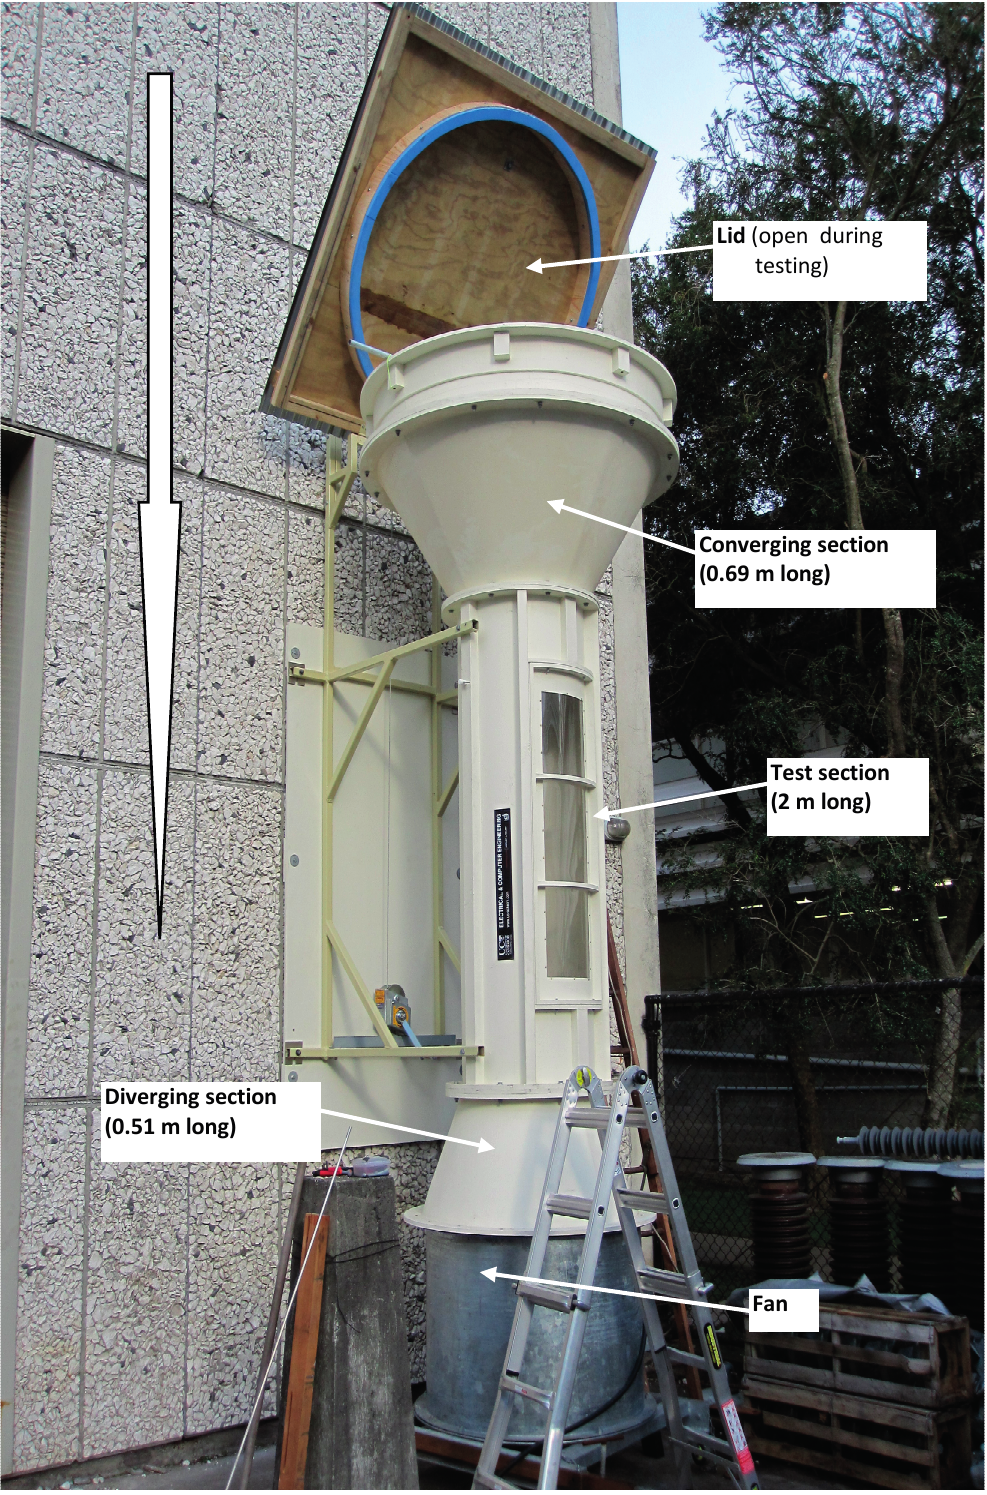
Figure 8. Wind tunnel used for validating rocketry systems before